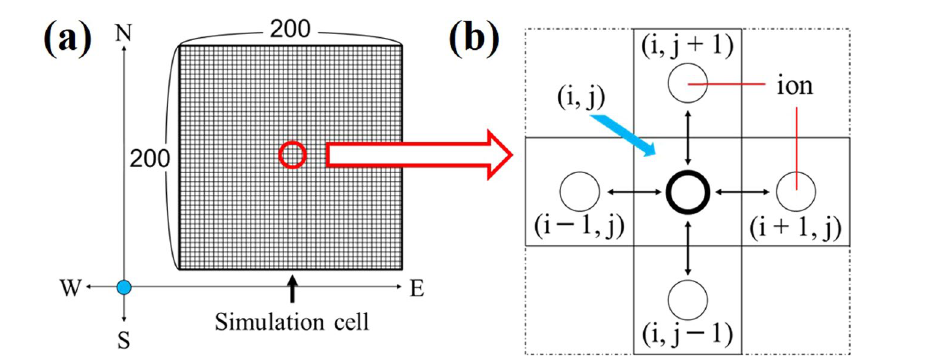
Figure 9. ( a ) Illustration of the calculation area for the computer simulation. ( b ) Is the enlarged